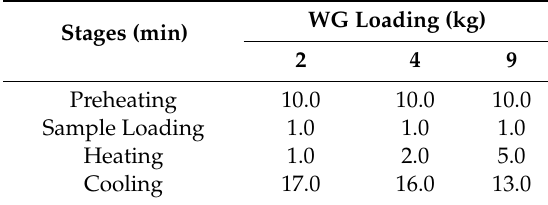
Table 1. Time allocation of each stage for wheat germ (WG) drying with 2, 4, and 9 kg. Stages